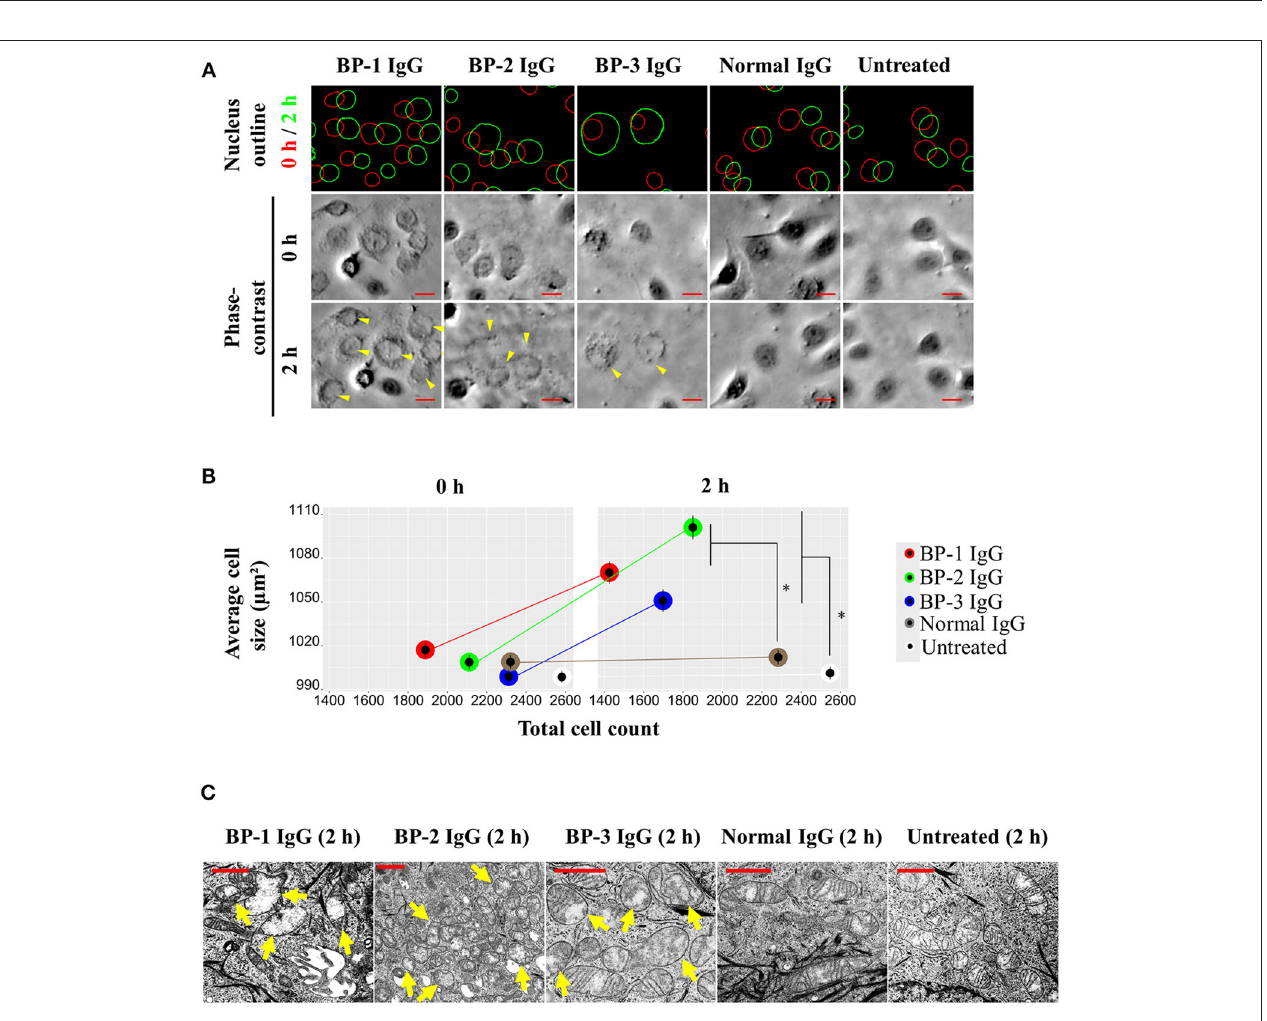
FIGURE 6 | Changes in the mitochondrial morphology in NHEKs treated with BP IgG. NHEKs were stained with Hoechst 33342 and then stimulated with BP IgGs (BP-1, BP-2, and BP-3) or normal IgG. (A) Nuclei were labeled at 0h (red circle) and 2h (green circle); the whole-cell area is shown with a phase-contrast image. Arrows indicate enlarged cells. Scale bar 20 µ m. (B) Average cell sizes at 0 and 2h were calculated from at least 1,500 individual cells per group. Two-way ANOVA was used for the statistical analysis. * p -value < 0.05. (C) TEM images of mitochondrial morphology in NHEKs that had been incubated with the indicated IgGs for 2h. Damaged mitochondria are indicated with arrows. Scale bar 1 µ